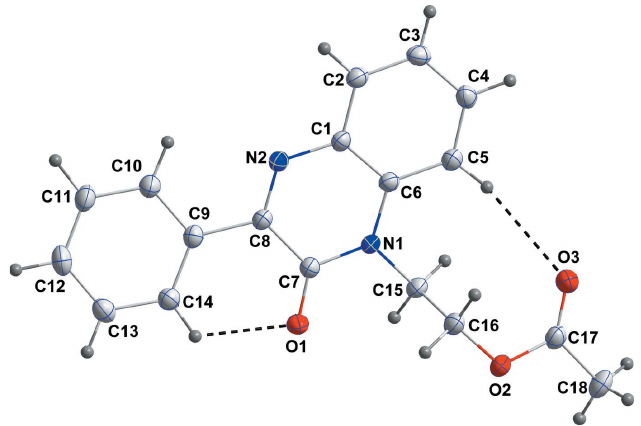
Figure 1 The title molecule with labelling scheme and 50% probability ellipsoids. The intramolecular C—H (cid:2)(cid:2)(cid:2) O hydrogen bonds are shown by dashed